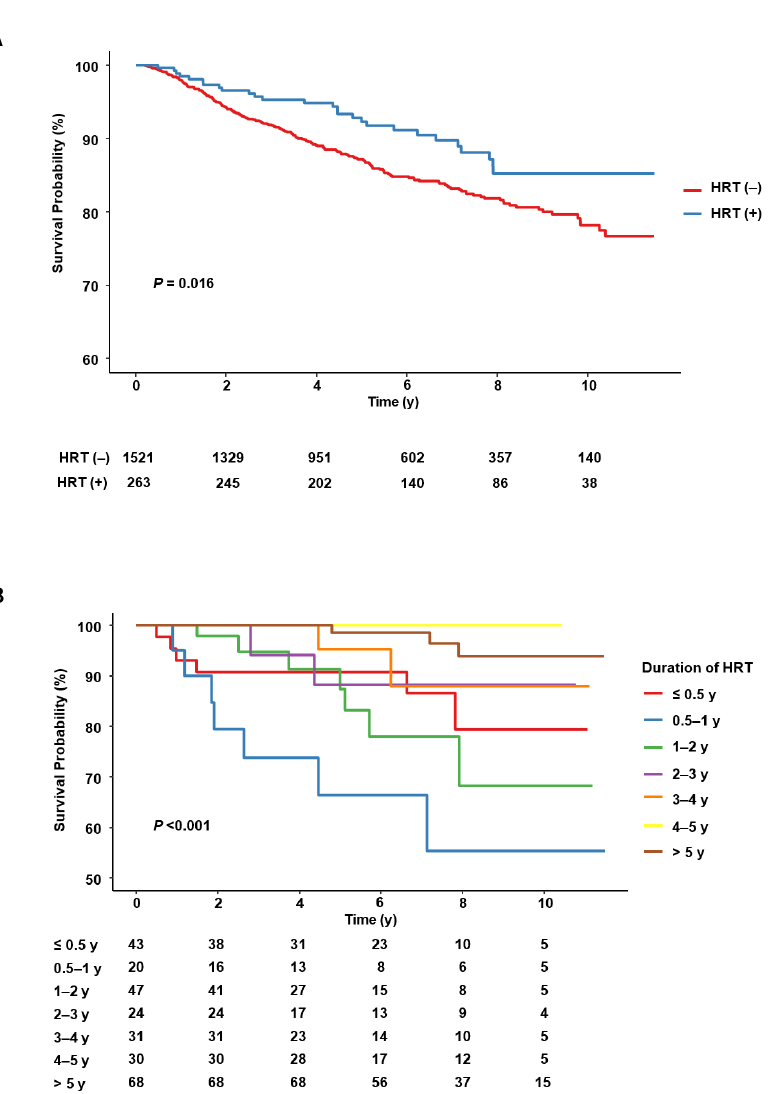
Figure 2. OS according to HRT use and duration in women with ovarian cancer. ( A ) OS according to HRT, ( B ) OS according to HRT